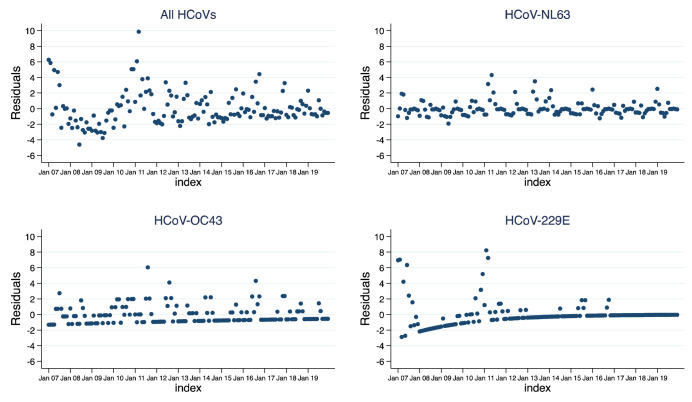
Plot of time series model residuals against month separated by HCoV type using pneumonia surveillance data at Kilifi County Hospital, Kilifi, Kenya 2007–2019.See
Methods for statistical details.